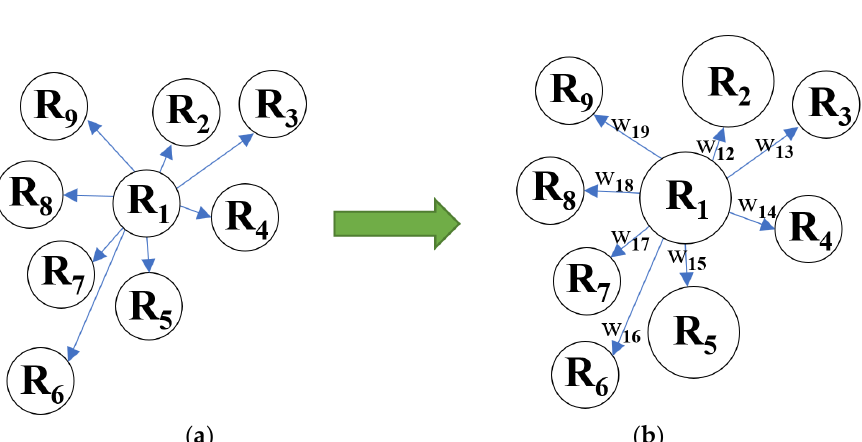
Figure 9. RAG and WRAG models. ( a ) RAG; ( b )